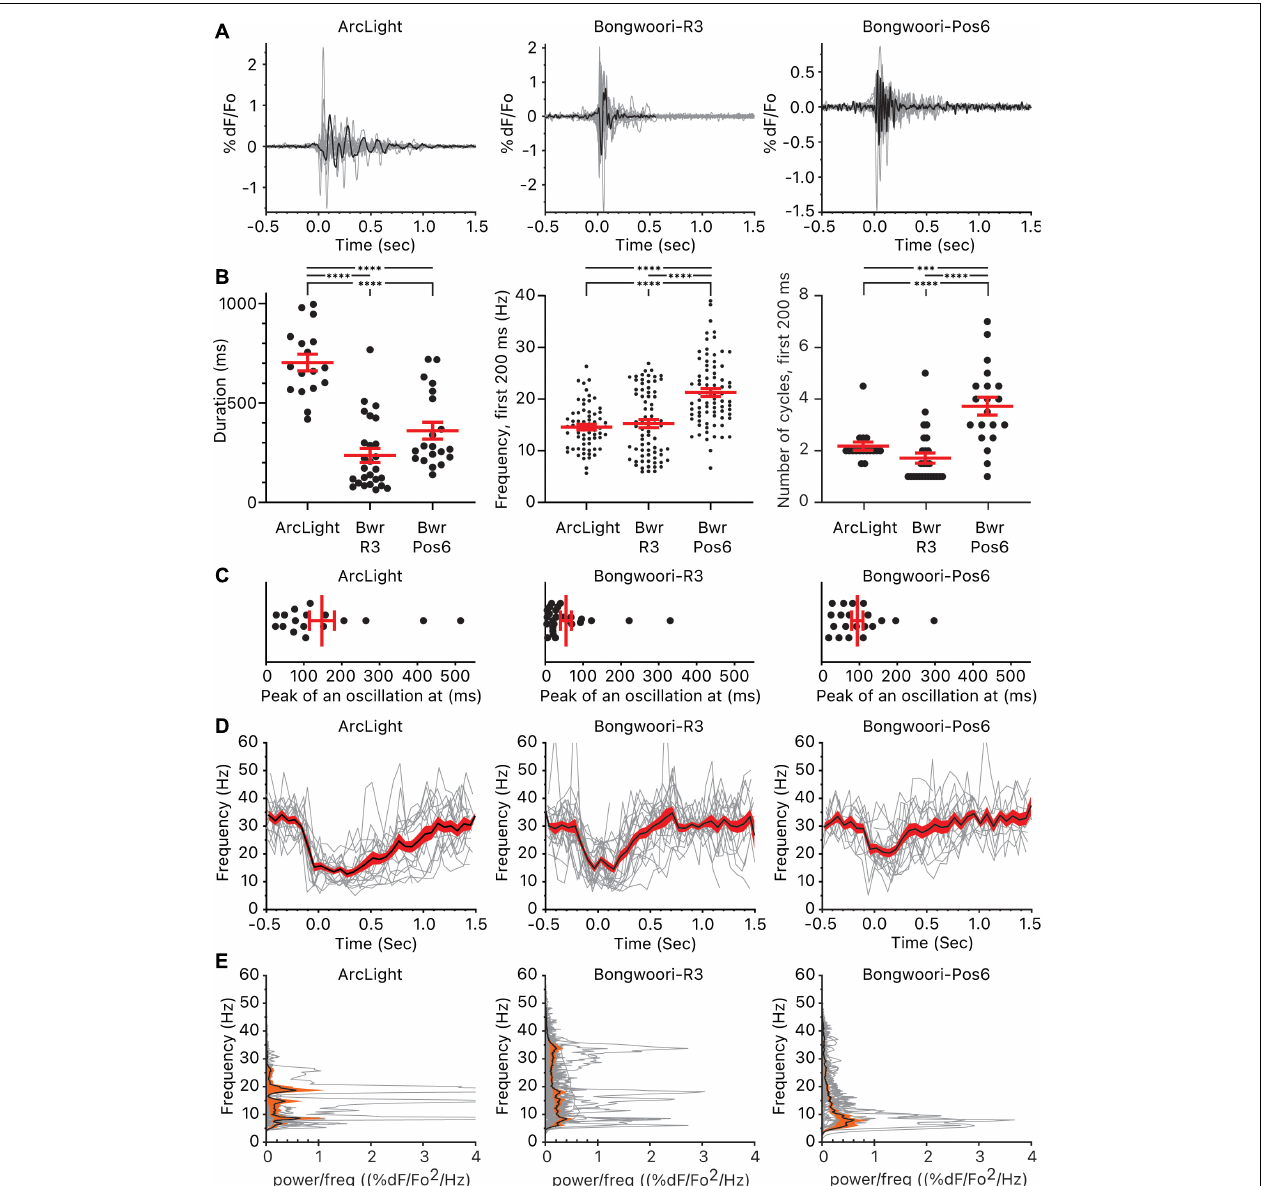
FIGURE 2 | Oscillations observed using ArcLight, Bongwoori-R3, and Bongwoori-Pos6. (A) Individual oscillation waveform (gray) and the representative oscillation waveform (black) plotted over time. The number of mice, slices, and oscillations for each GEVI is as follows: ArcLight, 4 mice, 5 slices, 17 oscillations. Bongwoori-R3, 8 mice, 11 slices, 26 oscillations. Bongwoori-Pos6, 3 mice, 4 slices, 20 oscillations. (B) The total duration of the oscillations, frequency, and the number of cycles during the first 200 ms of the oscillations. ∗∗∗ p < 0.001 and ∗∗∗∗ p < 0.0001 for one-way ANOVA and Tukey’s multiple comparisons test. (C) Timing of the absolute maximum % (cid:49) F/F 0 after the onset of the oscillations. (D) Frequencies of the individual oscillation waveforms (gray), the mean (black), and the squared error of the mean (red) of the frequencies plotted over time. (E) Power spectral densities of the individual oscillation waveforms (gray), the mean (black), and the squared error of the mean (orange) of the power spectral densities plotted over frequency. Bwr-R3, Bongwoori-R3; Bwr-Pos6,